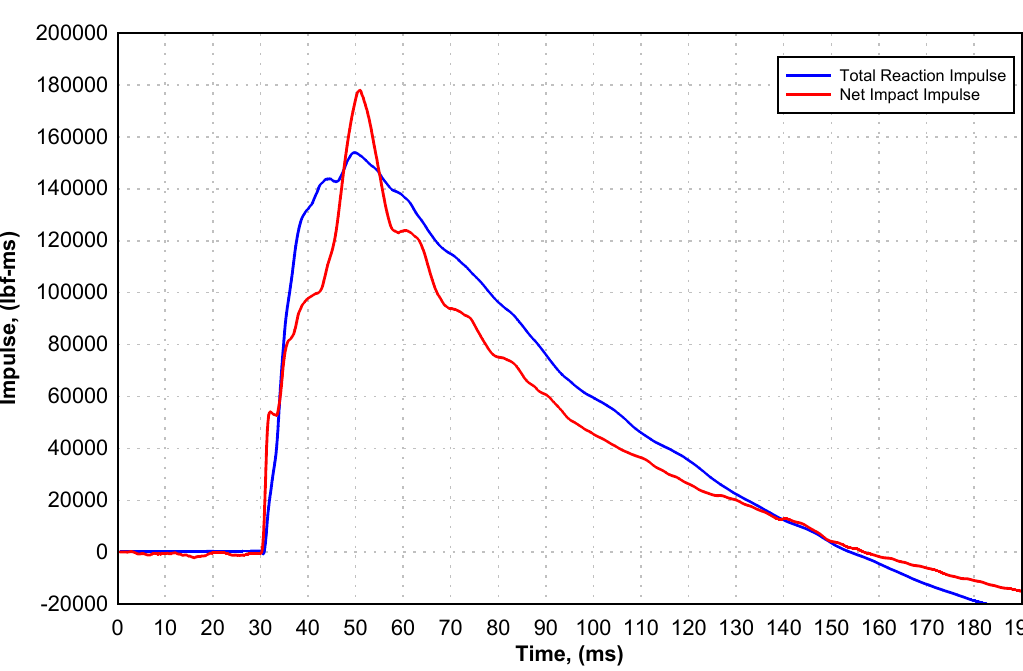
Figure 14. reaction forces and impulse for CLT5-10 specimen.